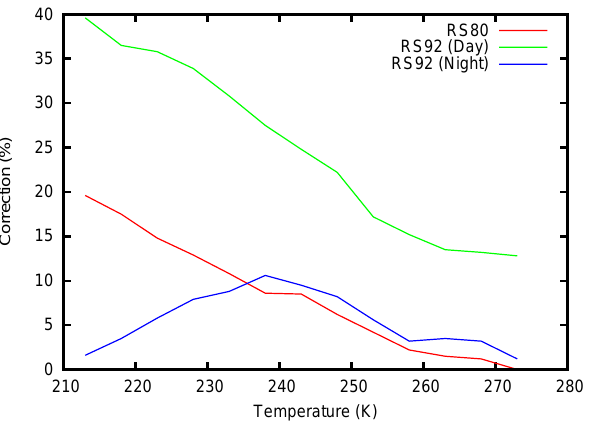
Fig. 3. A schematic diagram showing a high resolution RHi profile and how radiosonde RHi profiles were divided into 50-hPa of 100- hPa pressure layers. Each pressure layer could contain up to 100 high resolution RHi radiosonde observations.